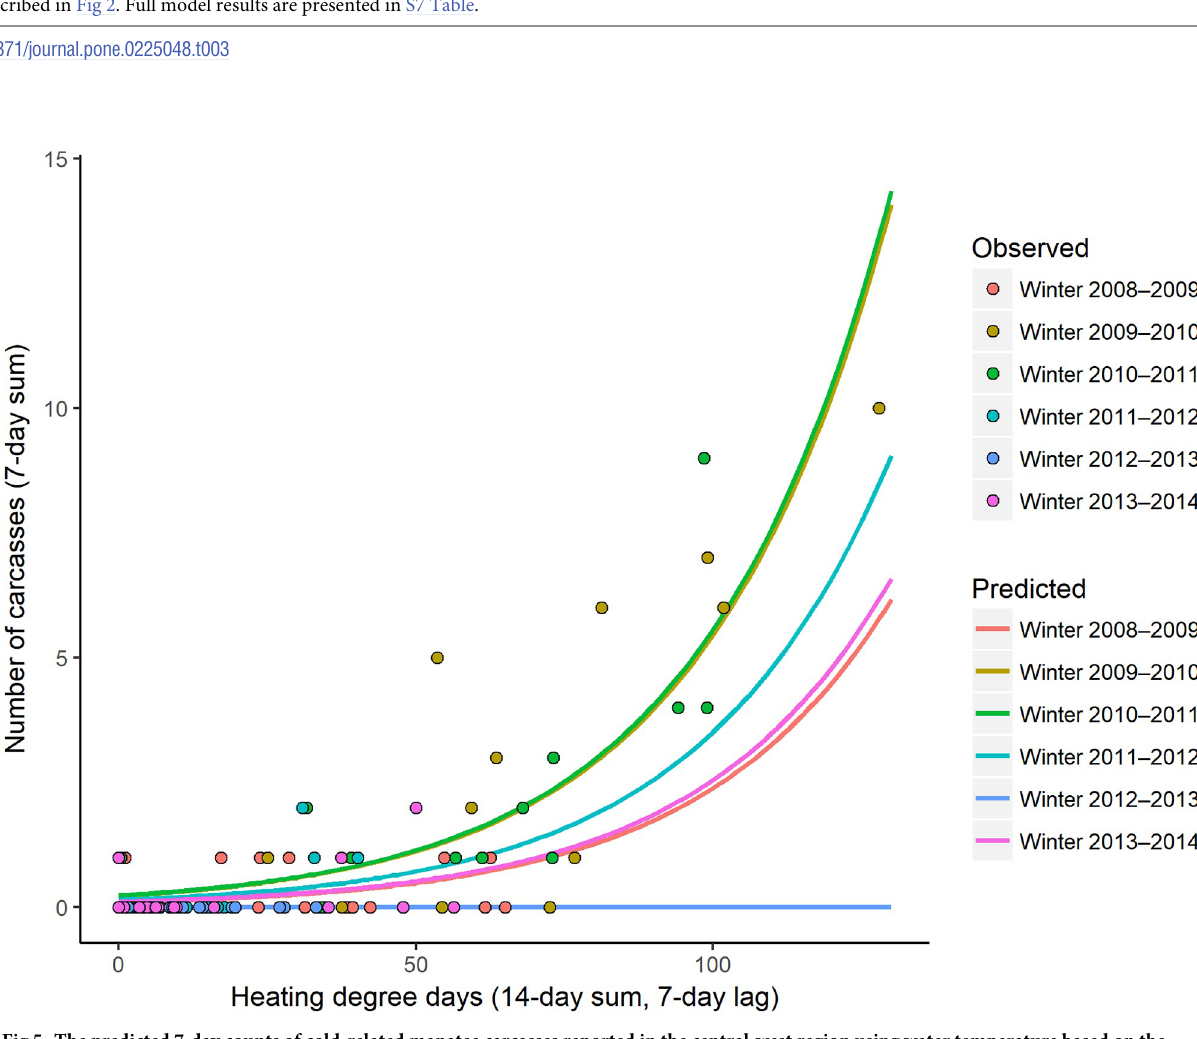
Fig 5. The predicted 7-day counts of cold-related manatee carcasses reported in the central-west region using water temperature based on the short-term temperature effect (14-day sum, lagged by 7 days; x-axis) by winter from the top-ranked model. Each line represents a different winter, and the circles represent the observed numbers of cold-related carcasses reported over 7 days color-coded by winter. Note that the prediction lines for winters 2009–2010 and 2010–2011 are nearly